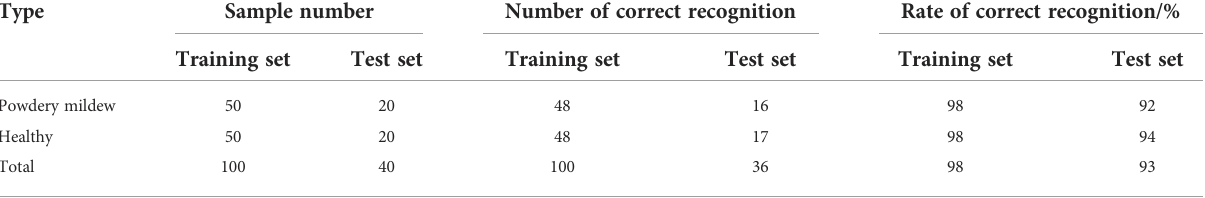
TABLE 5 Recognition results of cucumber powdery mildew (near